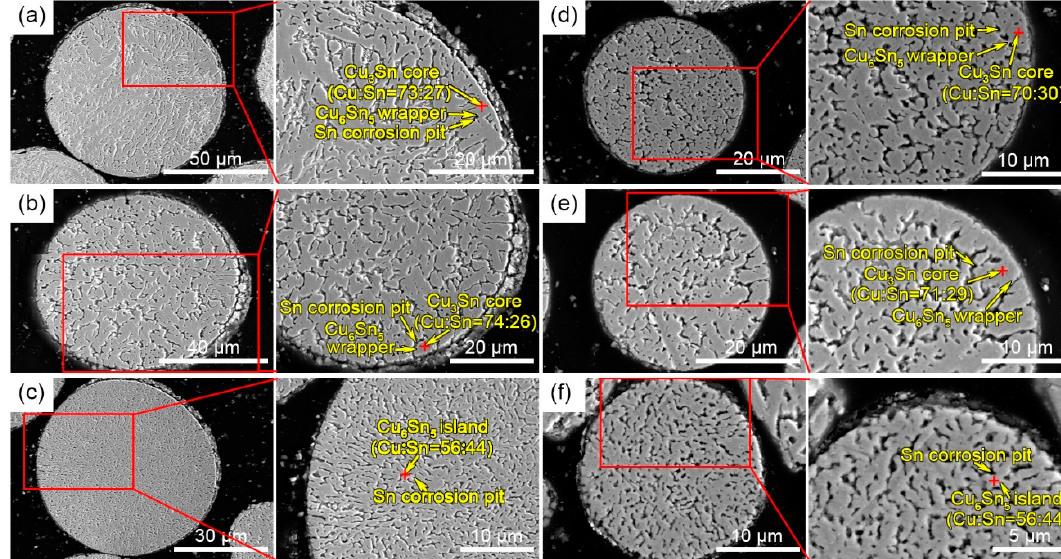
Figure 5. Interior microstructures of powders with different diameters with sizes of ( a ) 82 μ m, ( b ) 70 μ m, ( c ) 59 μ m, ( d ) 38 μ m, ( e ) 34 μ m, and ( f ) 22 μ m. Corresponding enlarged images and compositions are shown to the right. Materials 2019 , 12 , x FOR PEER REVIEW